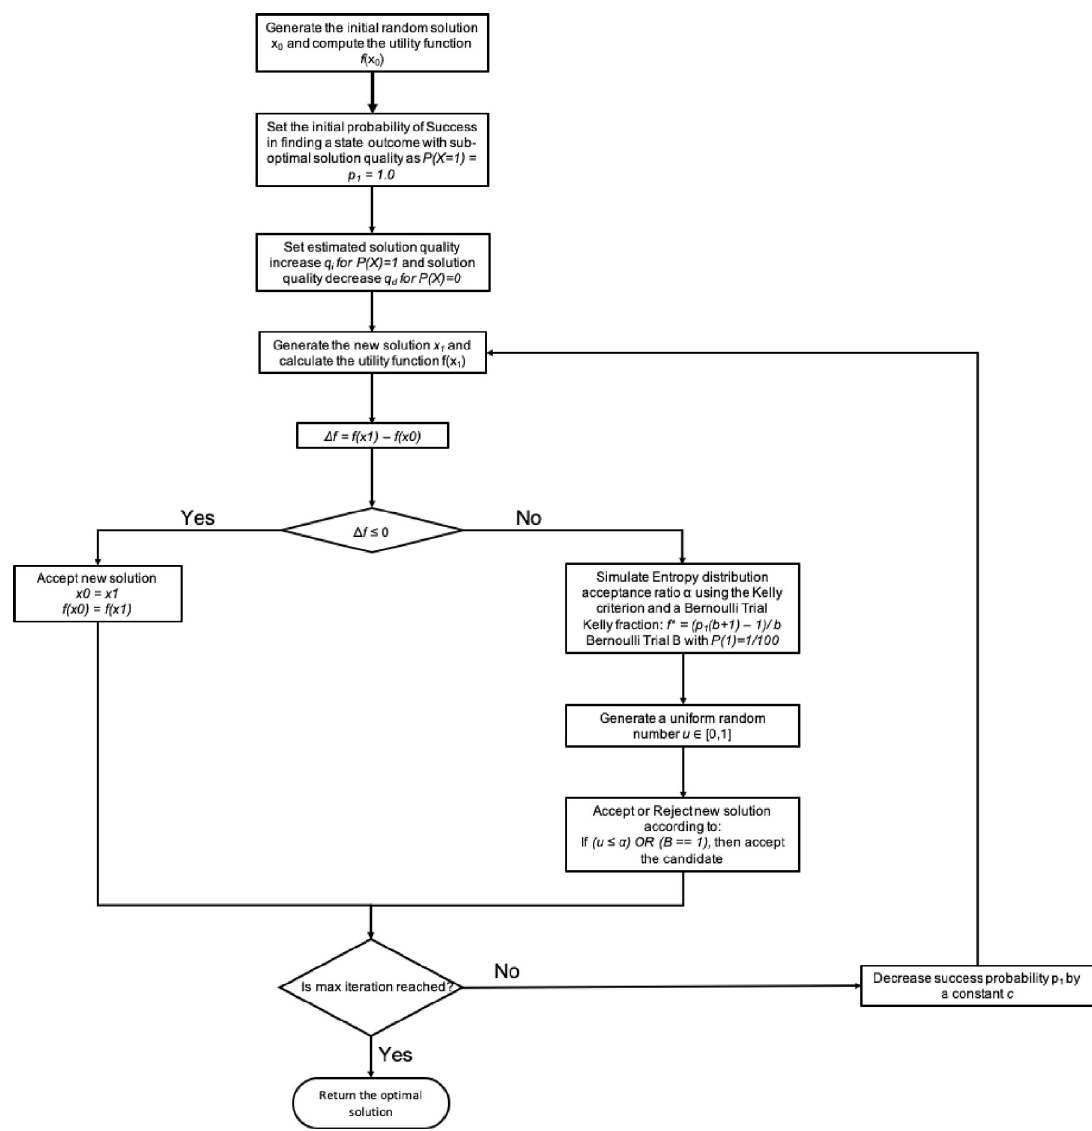
Fig 20. Flowchart for the Quantitative TSP algorithm based in information